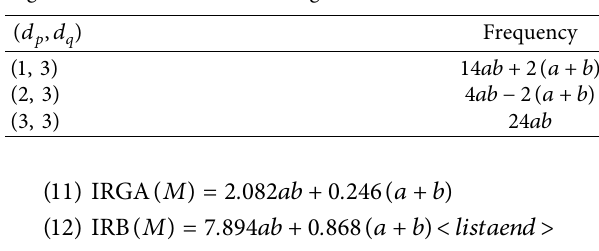
H N HCl [ a, b ] , established on 20 19 3